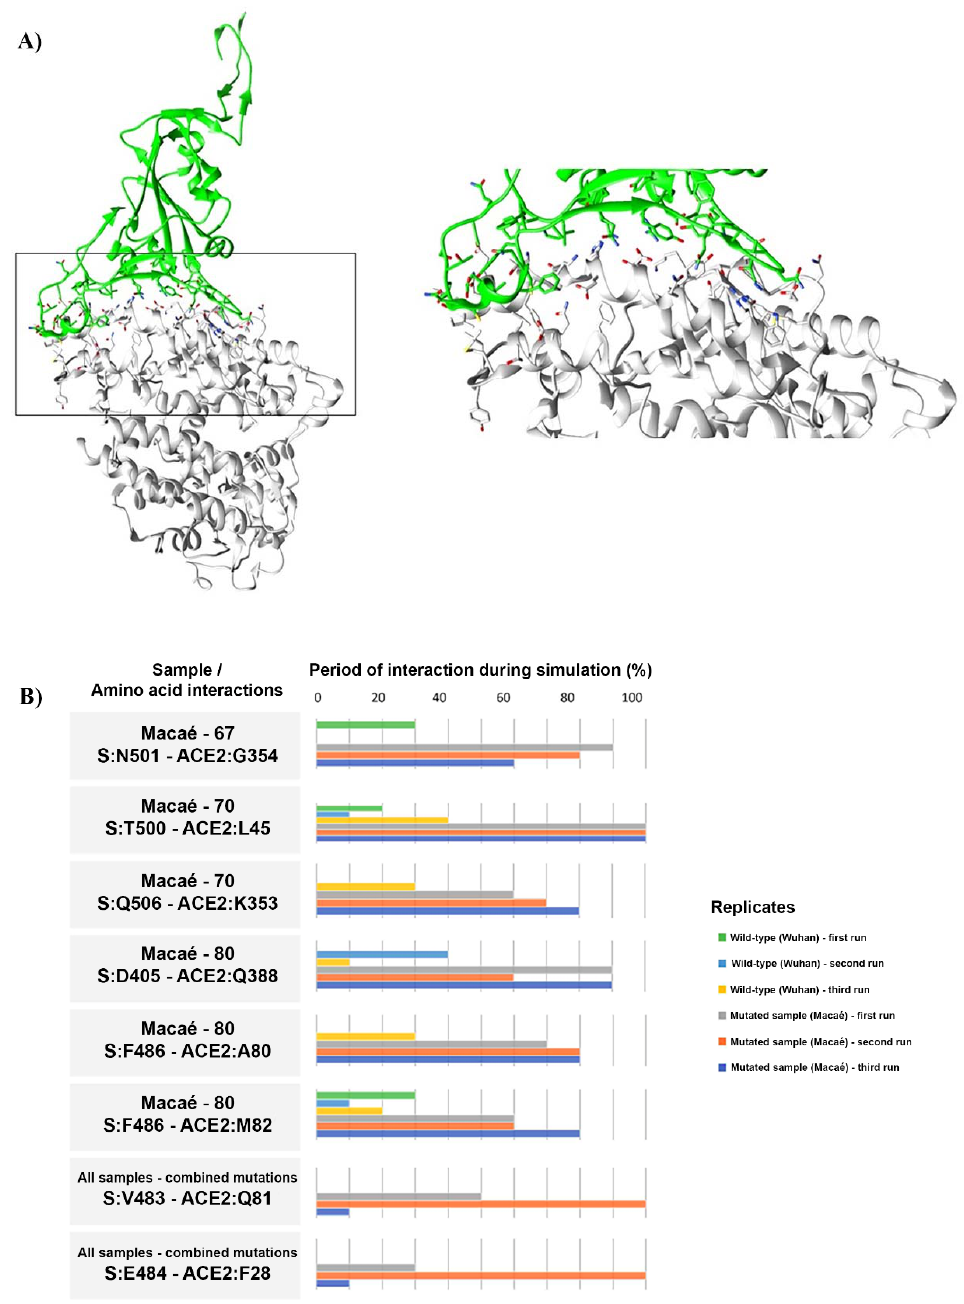
Figure 4. Molecular dynamics of the interaction between the spike protein and hACE2 show different profiles between the wild type and mutated spike isoforms from Macaé. ( A ) Molecular interaction profile from the spike protein of sample Macaé ‐ 70 with ACE2. Interactions between the spike protein and hACE2 are highlighted with a box and amplified for a more detailed view. ( B ) Histogram of the interaction profile from the wild type and the Macaé ‐ mutated amino acids of the spike protein. Percentage number of simulations indicates the period that the specific residue had interacted with hACE2 during 10 nanoseconds of molecular dynamics.